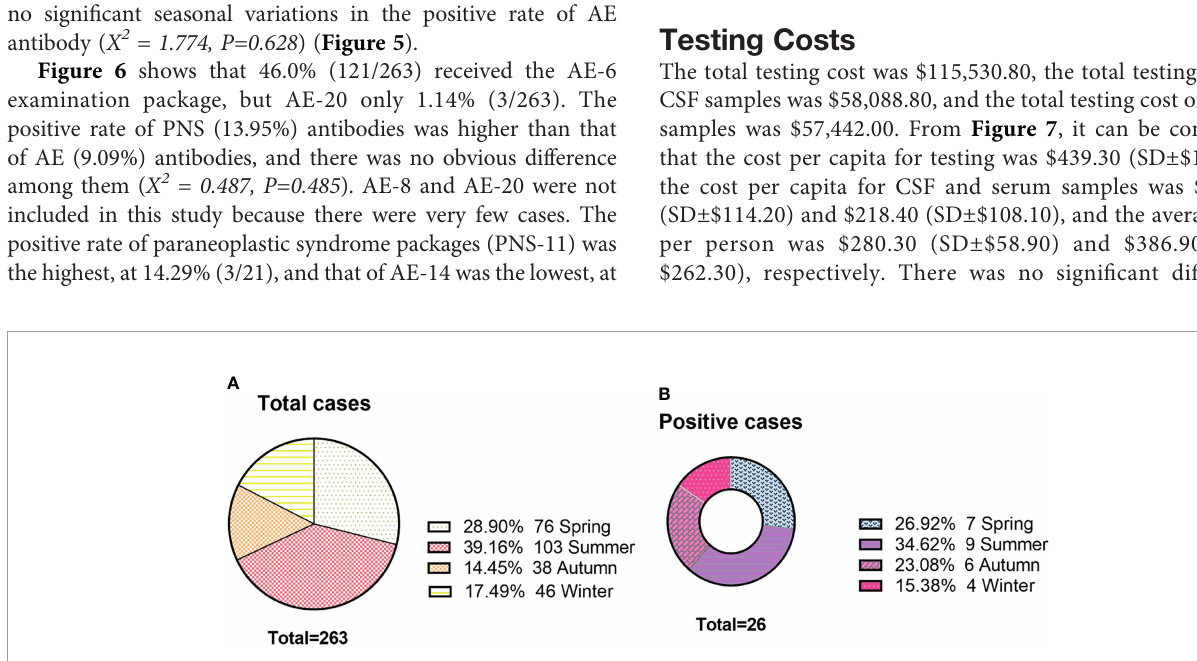
FIGURE 5 | The seasonal distributions of antibody detection. (A) The seasonal distributions of cases; (B) The number of positive cases among different seasons.